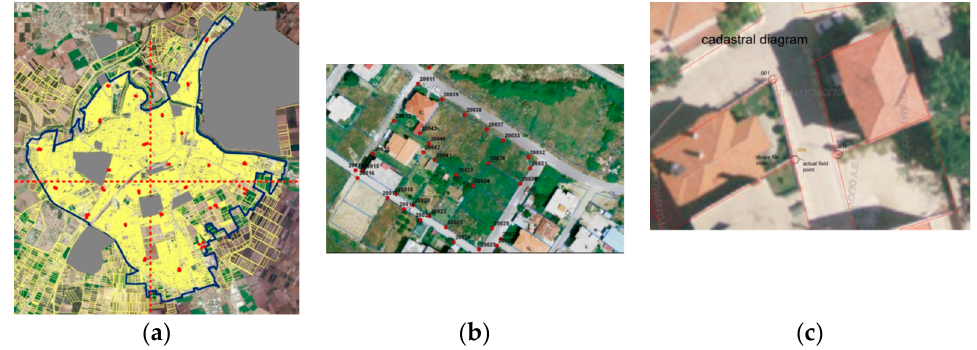
Figure 18. ( a ) Field measurement planning. ( b ) Field measurements ( c ). Identifying and targeting checkpoints in cadastral basemap. Source: [36]. checkpoints in cadastral basemap. Source: